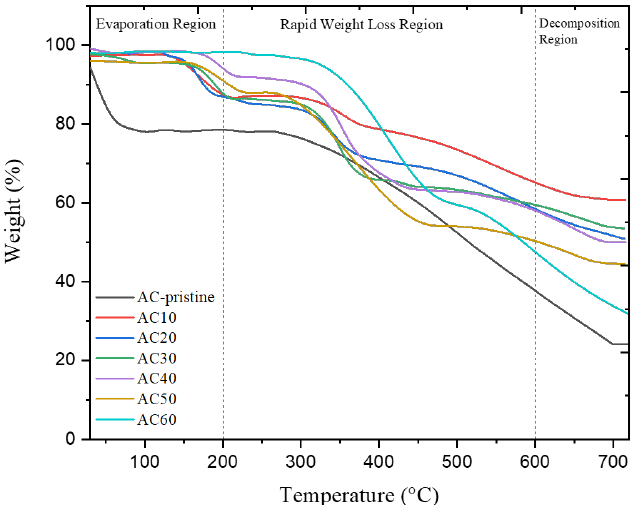
Figure 5. TGA profiles for fresh and functionalized AC under N 2 flow.